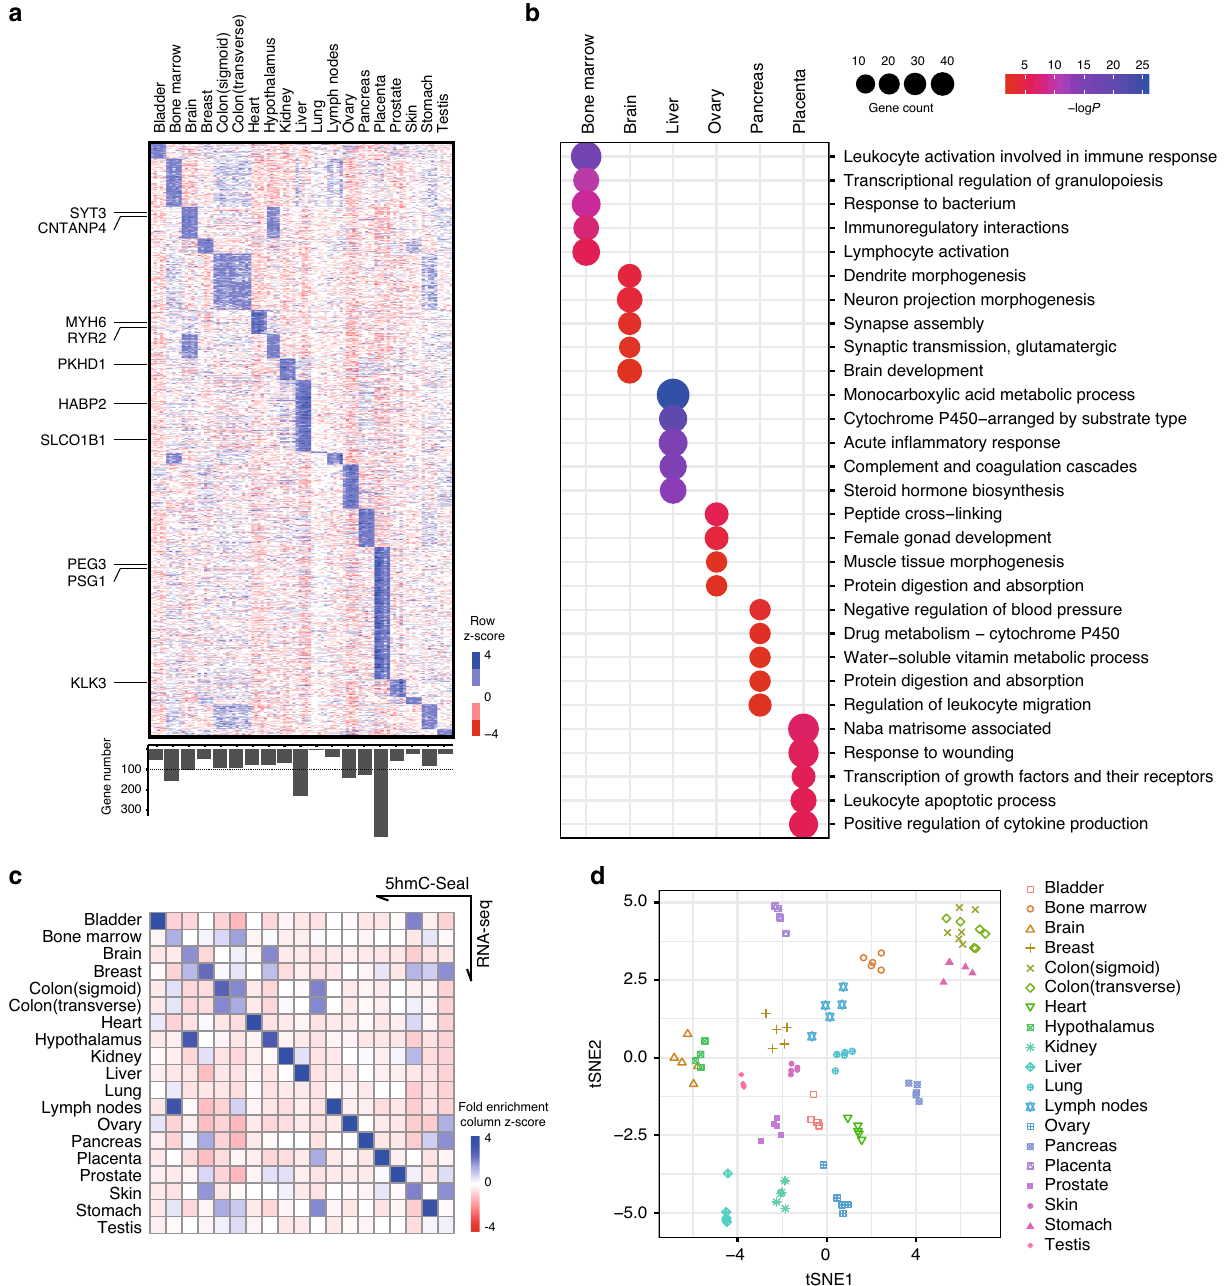
Fig. 2 Tissue-speci fi c, 5hmC-enriched genes are associated with highly tissue-speci fi c functions. a Relative 5hmC-modi fi cation levels on tissue-speci fi c 5hmC-enriched genes in each tissue type. Rows are distinct 5hmC-modi fi ed genes. Higher z score indicates enrichment; lower z score indicate depletion of 5hmC signal. Lower panel, numbers of tissue-speci fi c 5hmC-enriched genes for each tissue type. Dashed line represents 100. b Functional enrichment for tissue-speci fi c 5hmC-enriched genes. Only tissues with over 100 tissue-speci fi c 5hmC-enriched genes are shown. Top 5 enriched functional terms are ranked by enrichment signi fi cance. c Heatmap showing fold enrichment of tissue-speci fi c 5hmC-modi fi ed genes with tissue-speci fi c expressed genes from accompanying RNA-Seq data. d t-SNE clustering of genomic 5hmC distributions on exons for all donor tissue samples. Colored symbols indicate the organ/tissue associated with each 5hmC pro fi